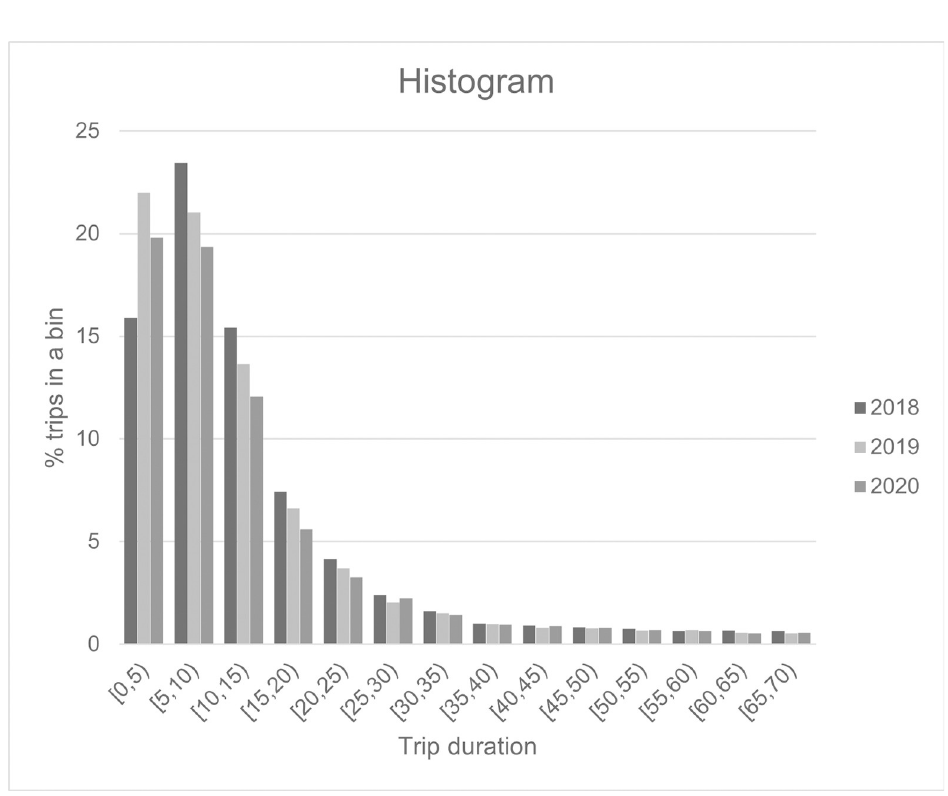
Fig 7. Histogram of trip